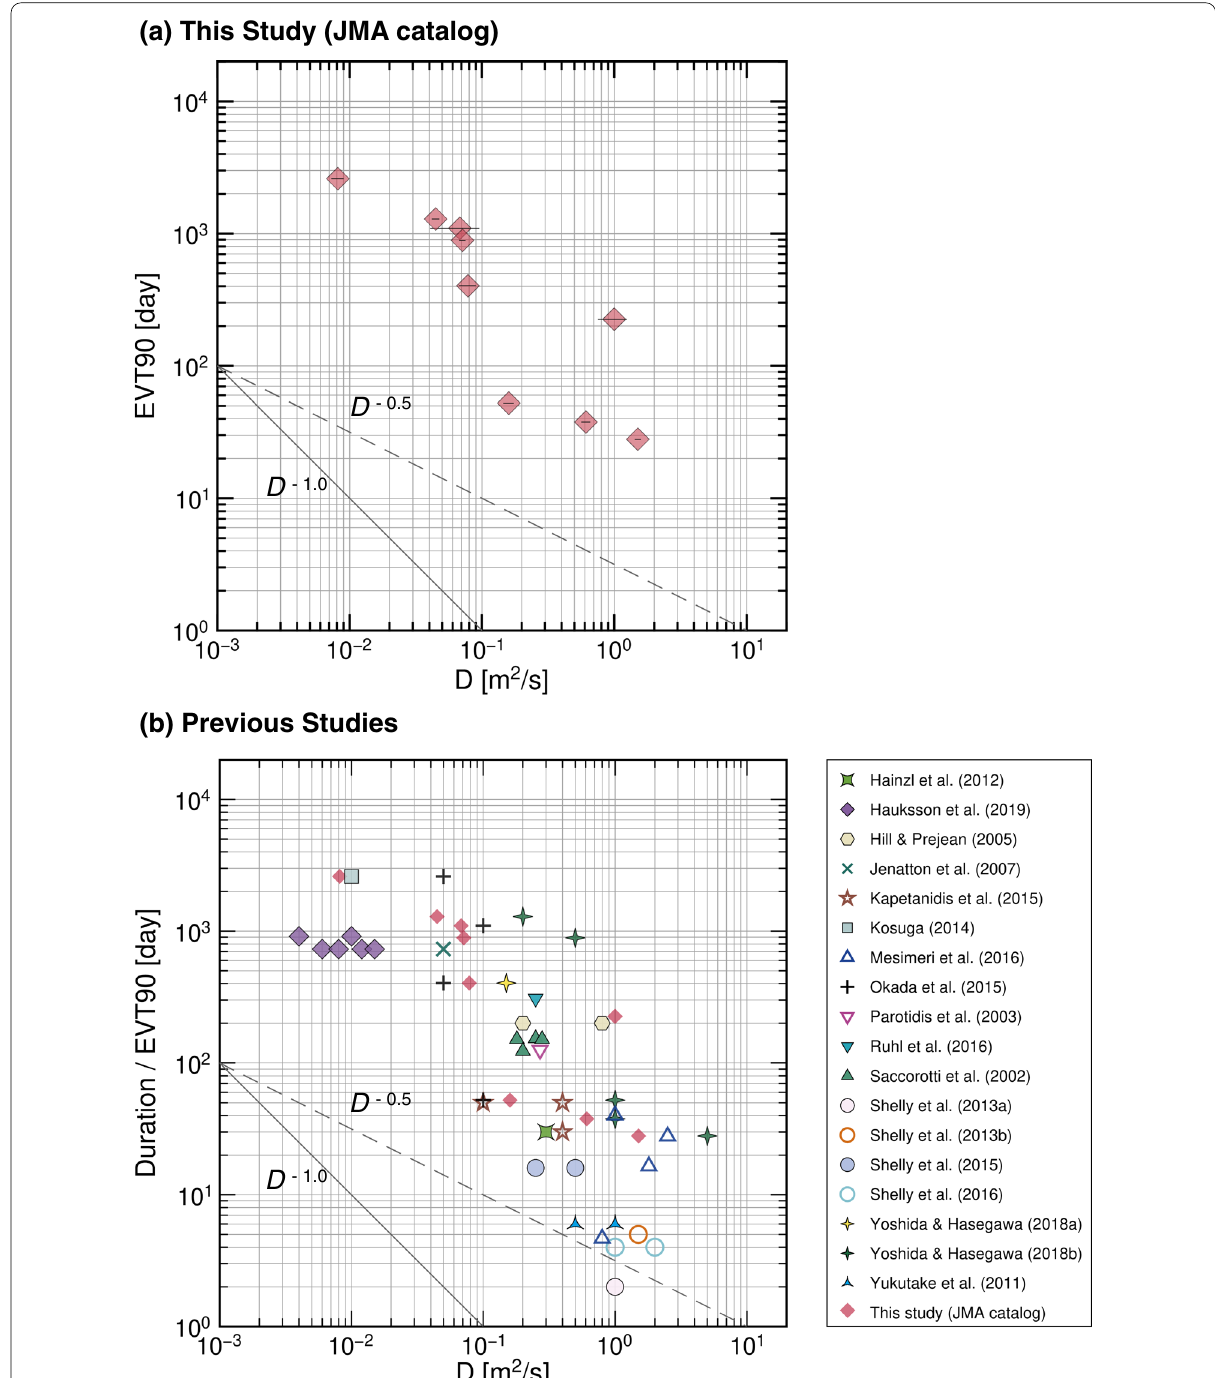
Fig. 4 Scatter plot between the diffusivity and swarm duration. a Red diamonds denote the points of the diffusivity ( D ) [m 2 /s] and the EVT90 [days] obtained in this study. Horizontal bars attached to the diamonds indicate the 2 σ range of the diffusivities. b Same as a but referred from previous studies listed to the right of the figure. Red diamonds show the values from this